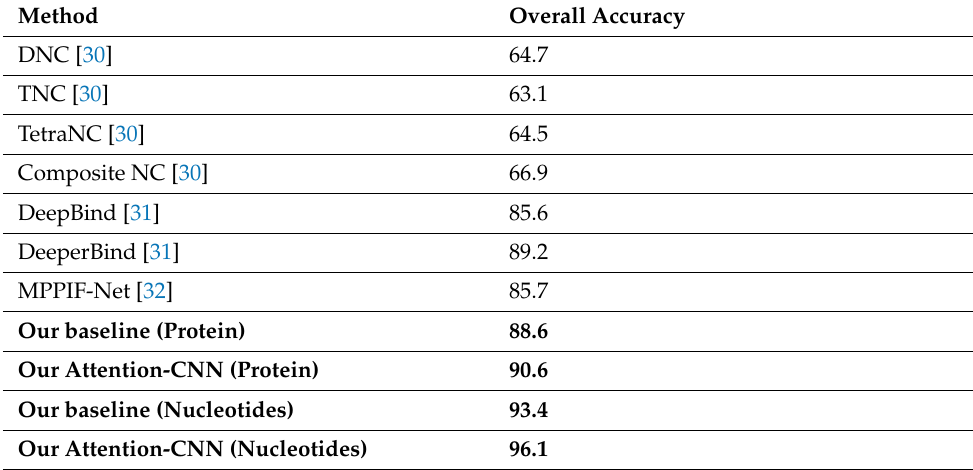
Table 2. Comparison with state-of-the-art nucleotide sequence analysis methods for COVID-19 variant classification on the test set of the